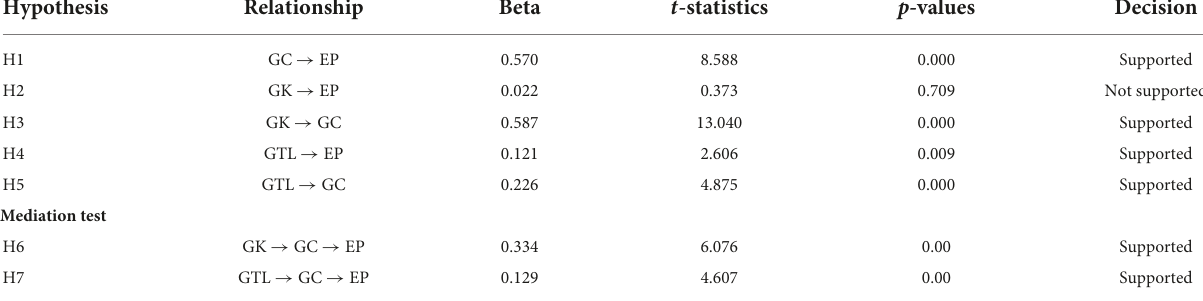
TABLE 6 Hypotheses